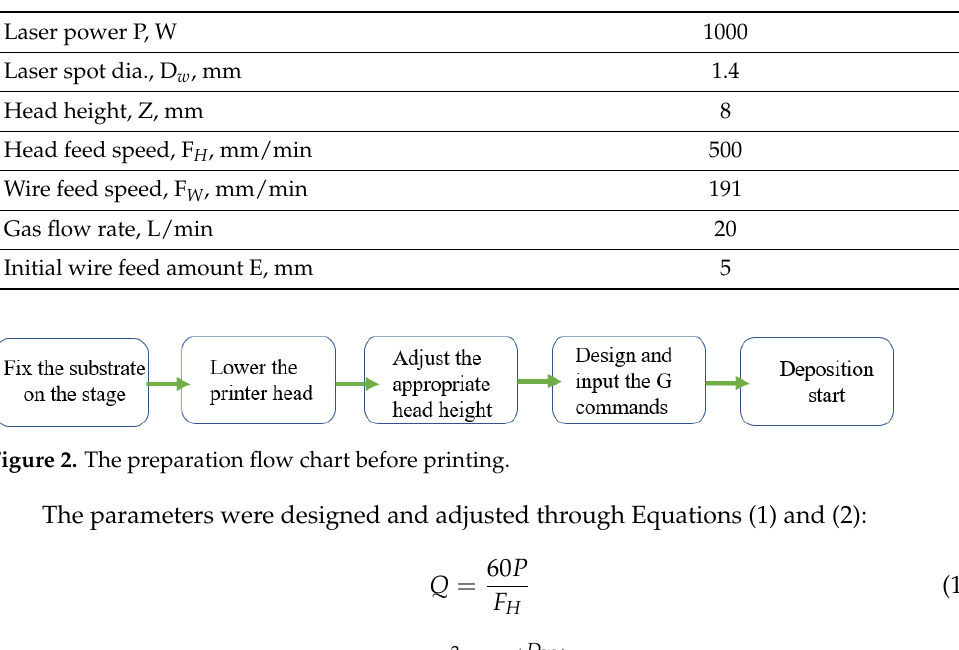
Table 2. Process parameters during printing.